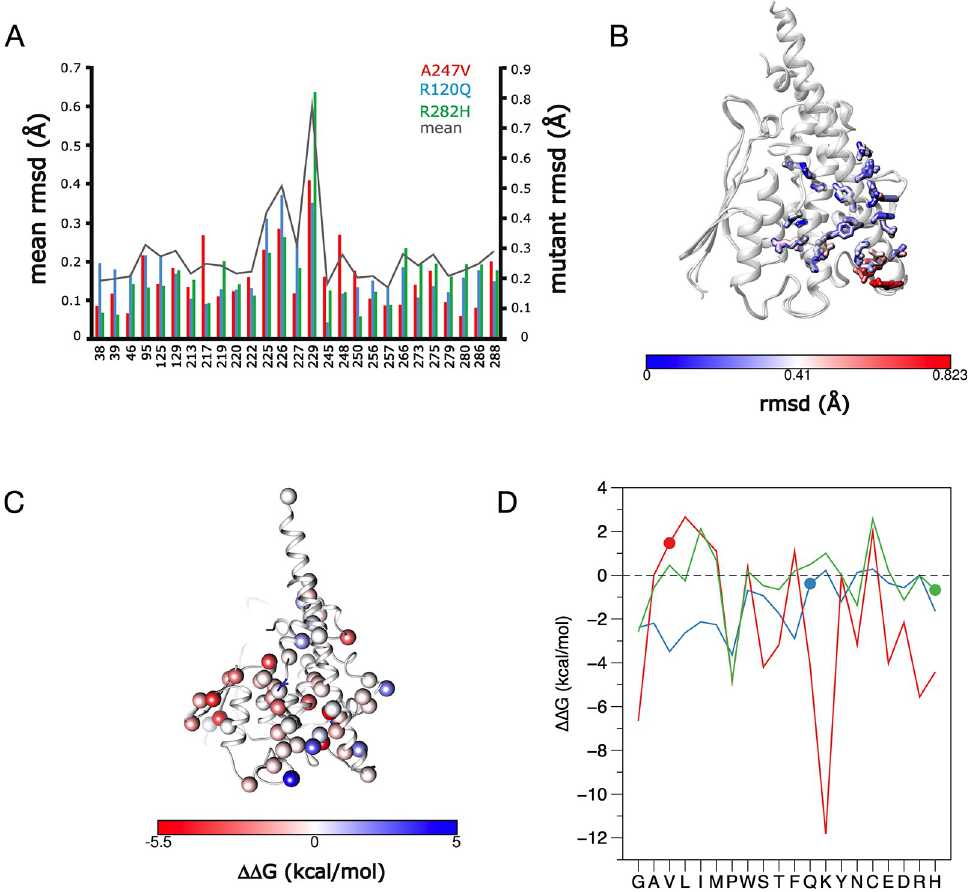
Fig 5. Structural bioinformatics analysis of the crystallised CMT variants. A. The C α deviation of each mutant vs. wild-type GDAP1 structure. The highest deviations can be found in the residue range 220–230. Shown are only the residues participating in the hydrogen bonding network. B. Mapping the results onto the structure, it becomes evident that the C-terminal end of helix α 6 deviates the most from wild-type GDAP1 on average. C. Average predicted ΔΔ G effect of GDAP1 mutations at CMT sites, as defined by CUPSAT. D. CUPSAT predictions for R120Q, A247V, and R282H being mutated into all possible amino acids. Note that a negative ΔΔ G in CUPSAT means destabilisation, and that A247V is falsely predicted as stabilising. The mutations studied here are marked with spheres. Ala247, red; Arg120, blue; Arg282, green.